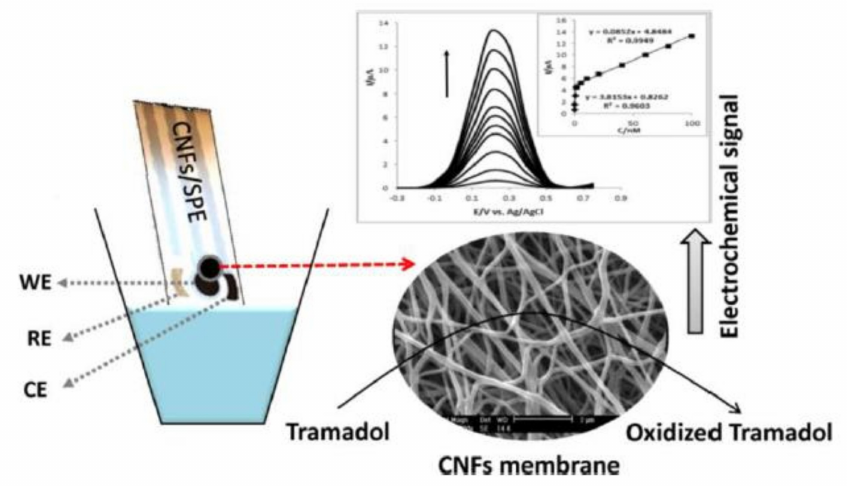
Figure 14. Schematic representation of SPE, microscopic image, and DPV detection. Reprinted from [90] with the permission of